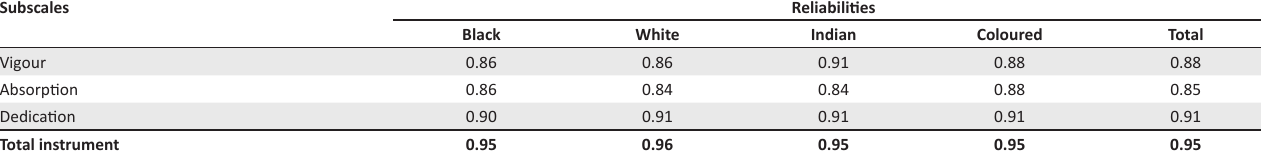
TABLE 3: Summary of the reliabilities of the total instrument and subscales per cultural group ( n = 2429).